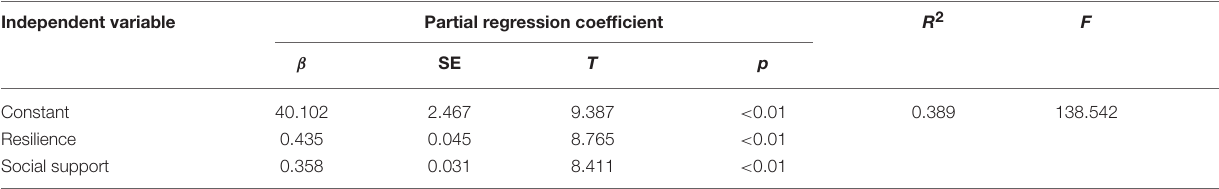
TABLE 4 | The regression results of the effects of perceived social support and resilience on quality of life. Independent